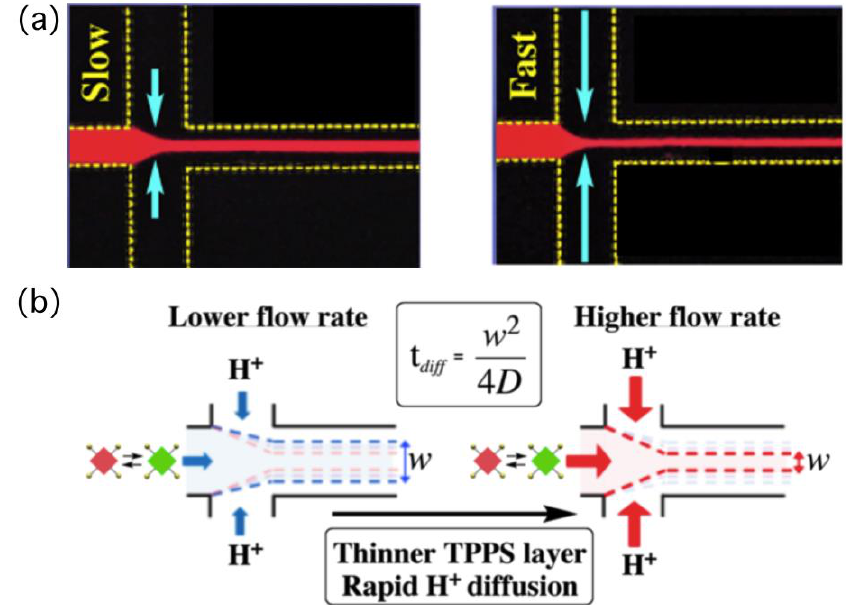
Figure 3. ( a ) Fluorescence microscopy images of an aqueous solution of TPPS injected from the central channel, and ( b ) a schematic representation of the effect of the flow rates on the width of the central flow (for the definition of t diff ; see the Supplementary Materials).